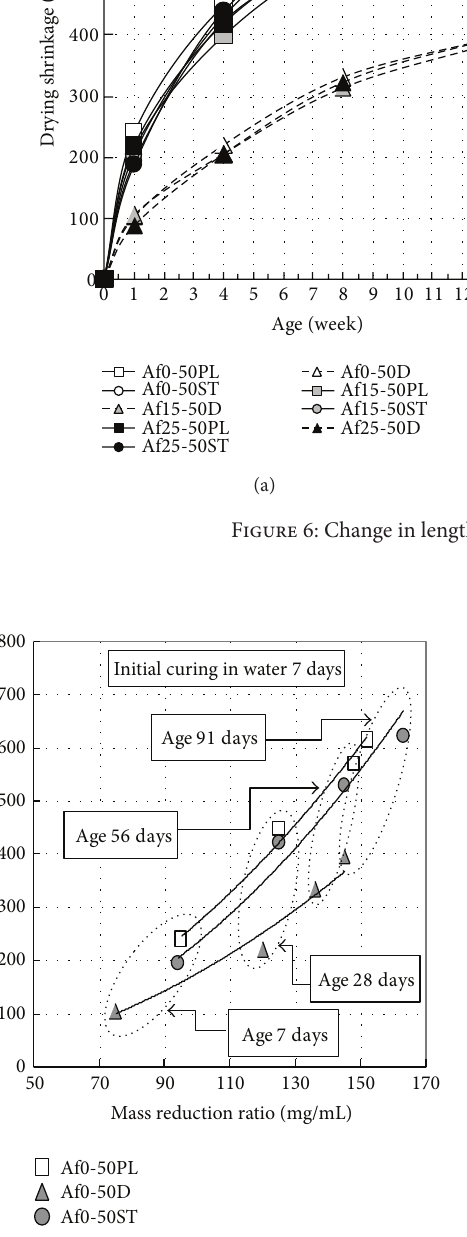
Figure 7: Relation between mass reduction ratio and drying shrink-